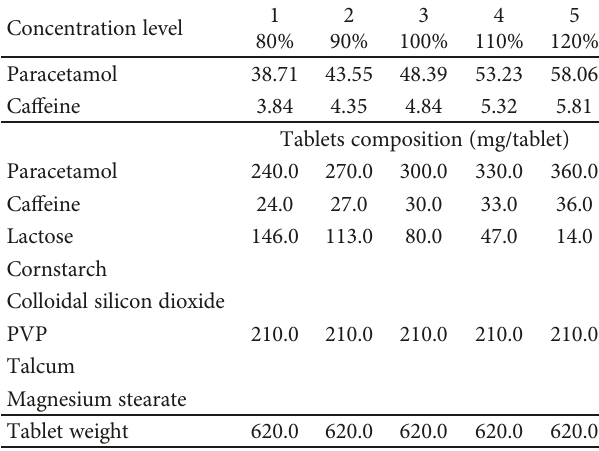
Table 1: Composition of calibration and validation samples. Concentration